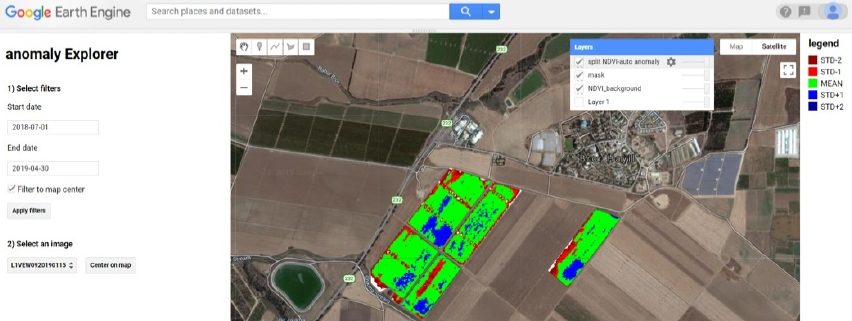
Figure 4. Anomaly Explorer app running in chrome browser with Sentinel-2 data presenting NDVI anomalies in five wheat fields in Saad on 15 January 2019.